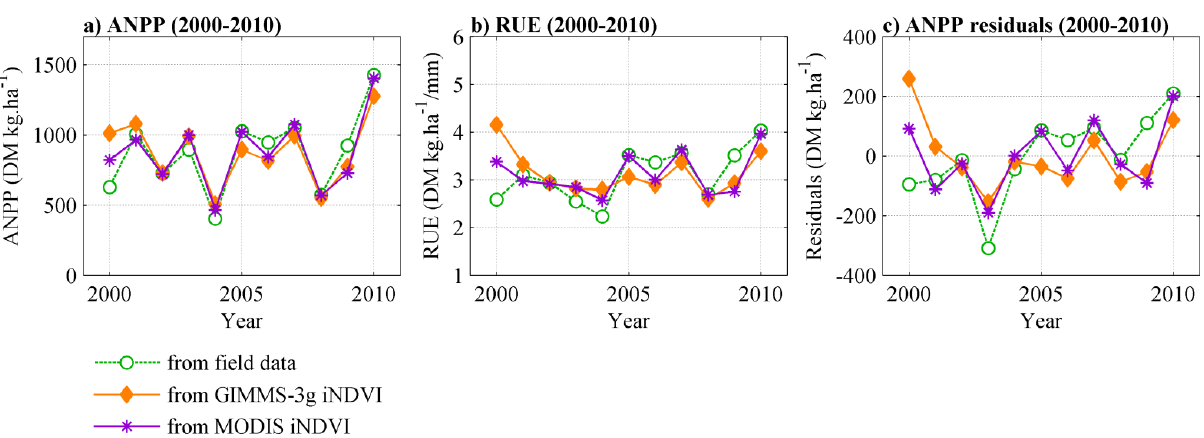
Figure A4. Estimates of ( a ) ANPP, ( b ) RUE and ( c ) ANPP residuals over 2000–2010 from field observations (green), GIMMS-3g iNDVI (orange) and MODIS iNDVI